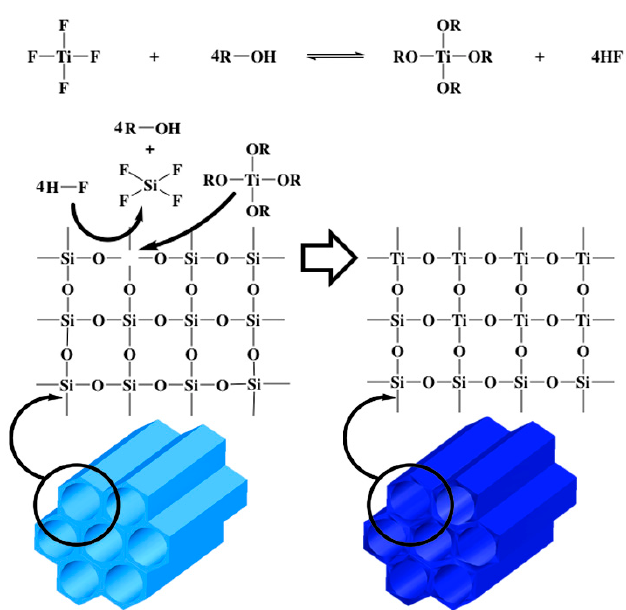
Figure 7. Schematic diagram of the in situ etching reaction of TiF 4 and SBA-15.